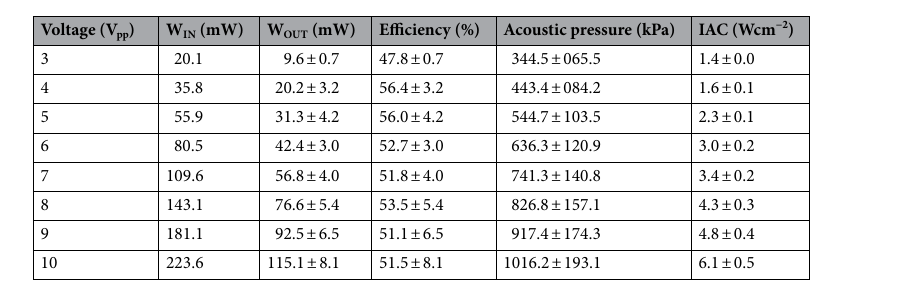
Table 1. Output parameters of the miniature focused ultrasound transducer used for the ex-vivo tissue experiments.